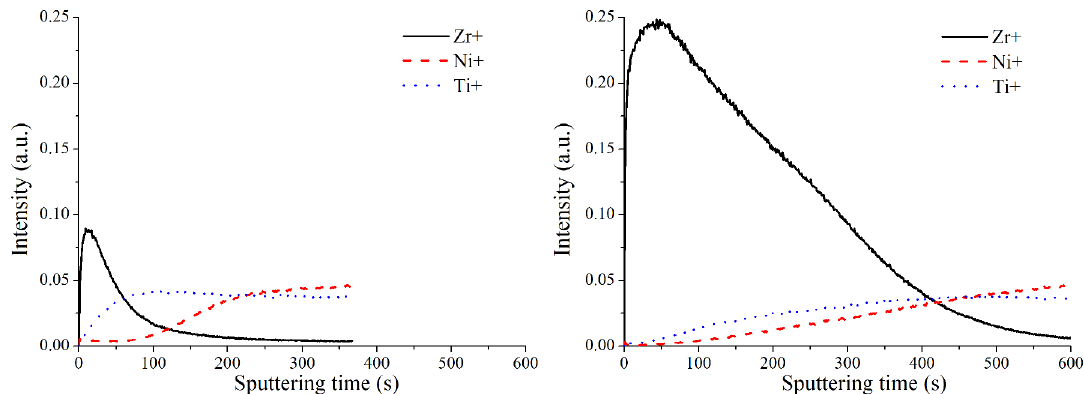
Figure 7. ToF-SIMS compositional depth profiling of Ni-Ti wire coated with ZrO2 (a) without prior electropolishing; and (b) with prior electropolishing.